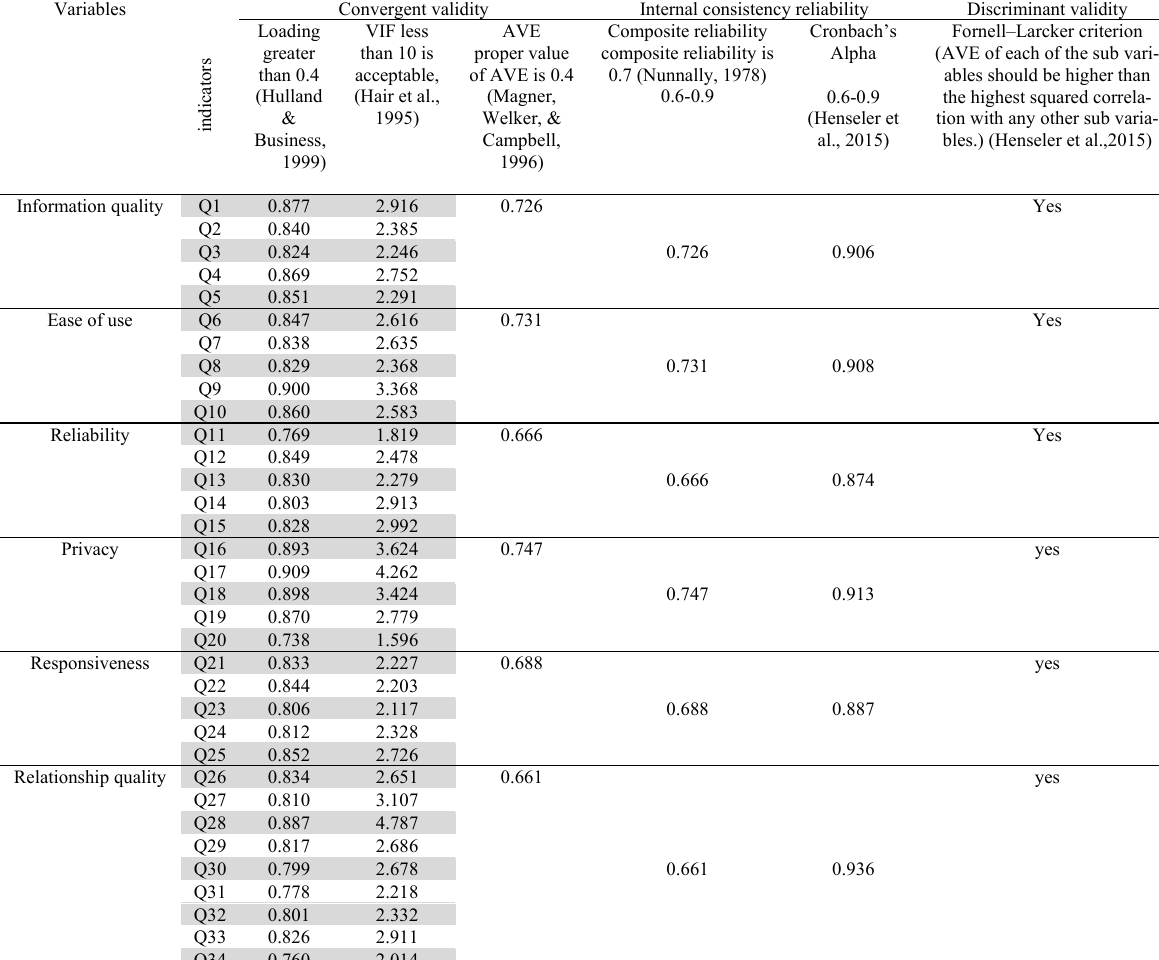
Results summary for Measurement model (outer model) Convergent & Discriminant validity Internal consistency